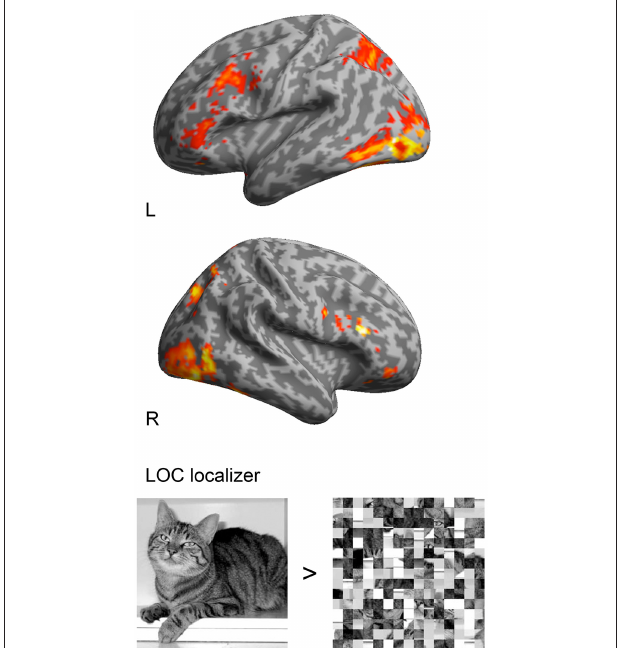
FIGURE 1 | Group analysis ( n = 14 ) of the LOC localizer (objects > scrambled objects) with a threshold of p < 0.05 , FSW corrected and superimposed onto a standard 3D inflated template in MNI space. Activations were found in lateral occipital cortex with the MNI coordinates 48, − 54, − 9 and − 45, − 54, −